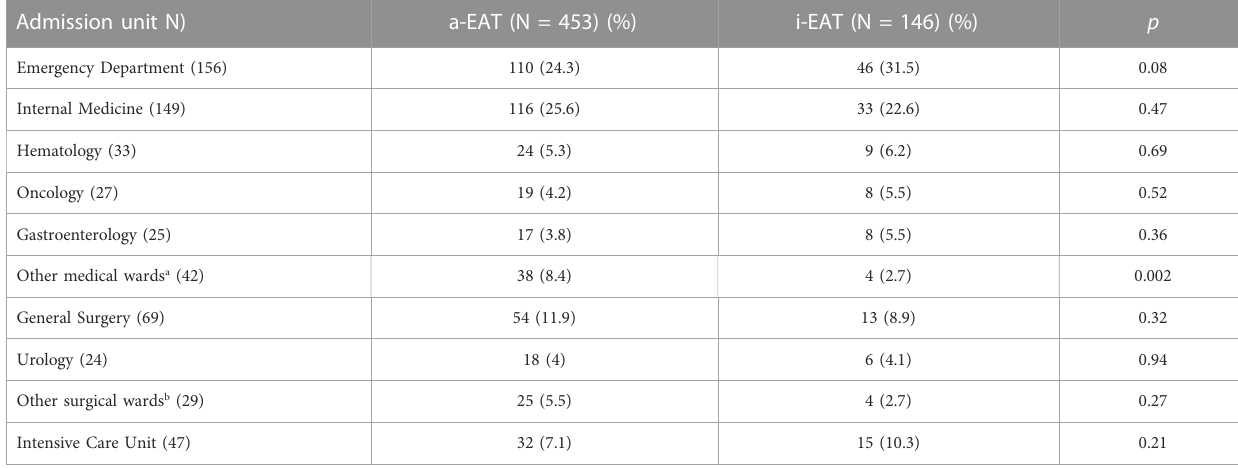
TABLE 4 Admission Unit of the BSI episodes and comparison between the a-EAT and i-EAT episodes in relation with the global antimicrobial appropriation. Admission unit N)